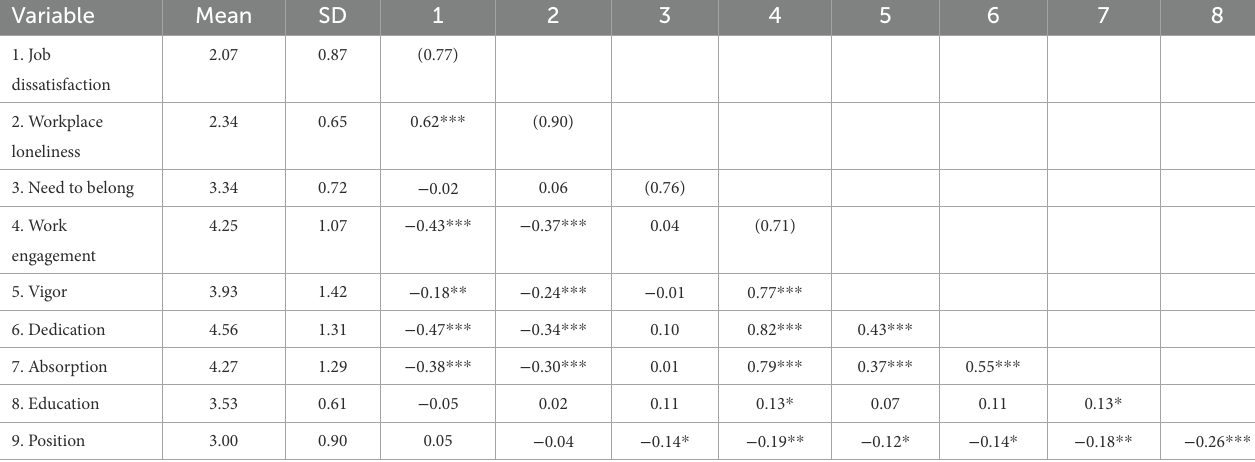
TABLE 2 Descriptive statistics, zero-order correlations, and reliabilities.